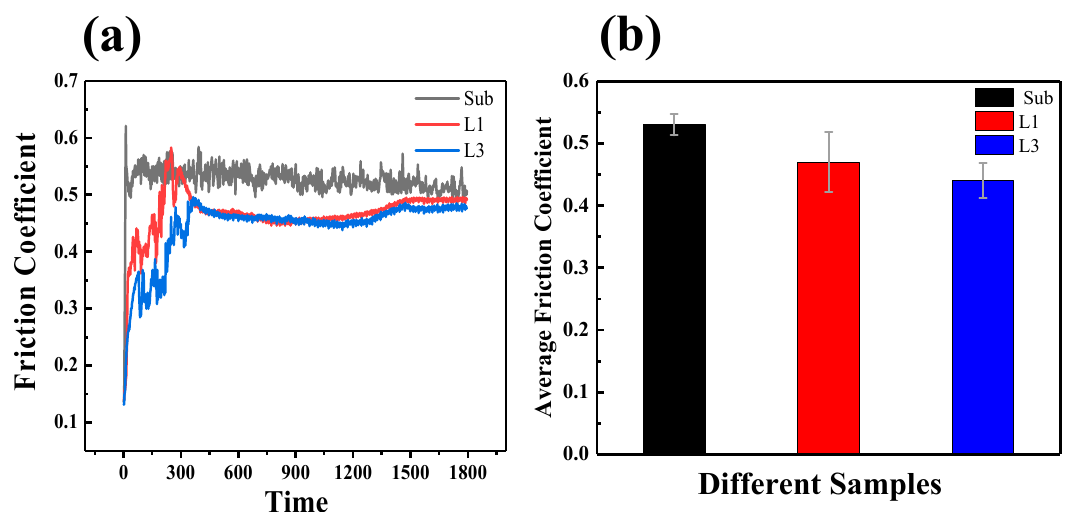
Figure 9. ( a ) Friction coefficient curves of the substrate (Sub), L1 and L3, ( b ) Histogram of average friction coefficient.